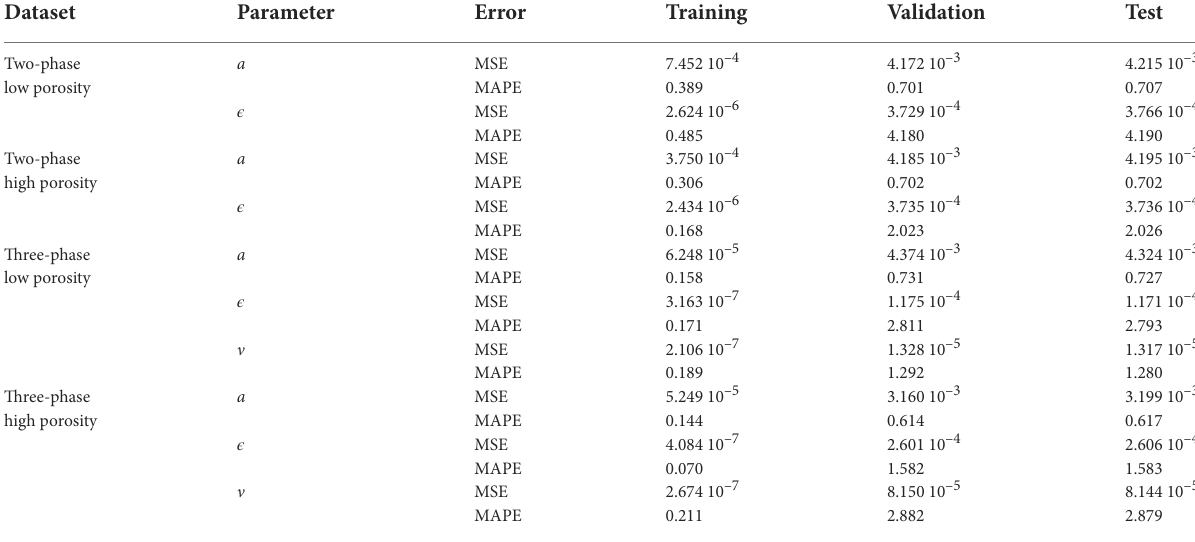
TABLE 2 Errormeasuresforthepredictionoftheparameters,whereMSEandMAPE(in%)isgivenforthetraining,validationandtestsets.